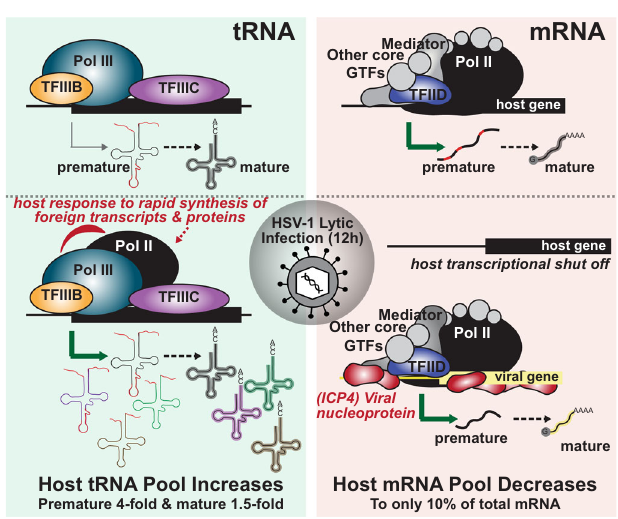
Antibodies . A list of all antibodies and the amount used per technique is located in Supplementary Table 1.